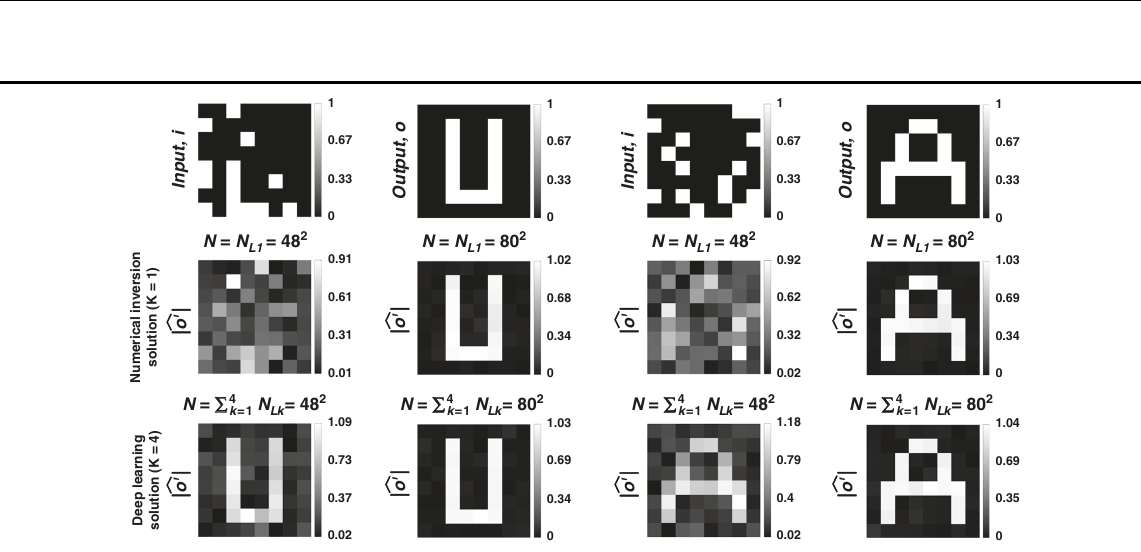
Fig. 11 Diffractive all-optical transformations and their differences from the ground truth, target transformation (A) presented in Fig. 10b